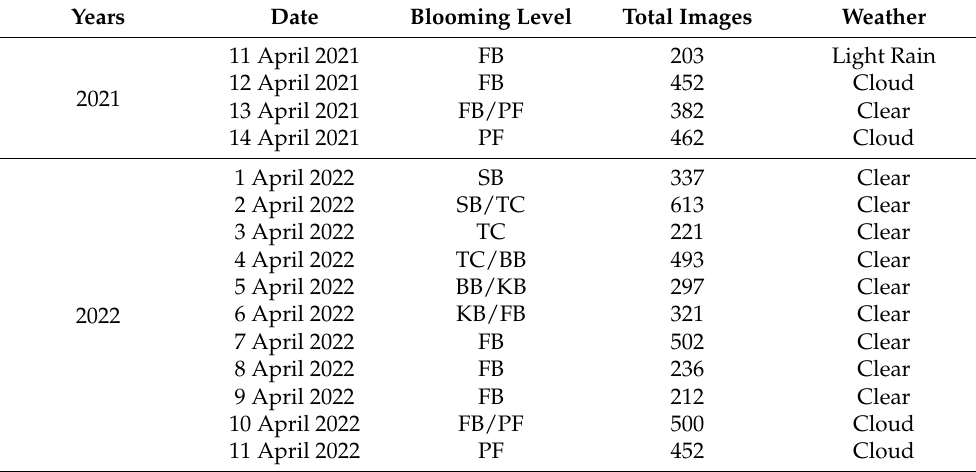
Table 1. Summary of the